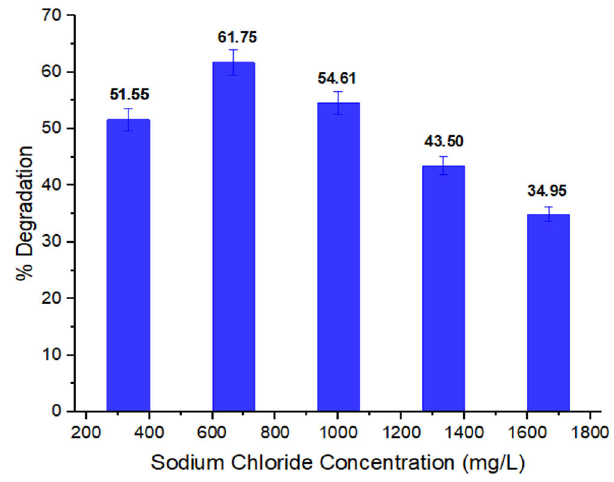
Figure 8. Effect of sodium chloride (mg/L) on dye % degradation.